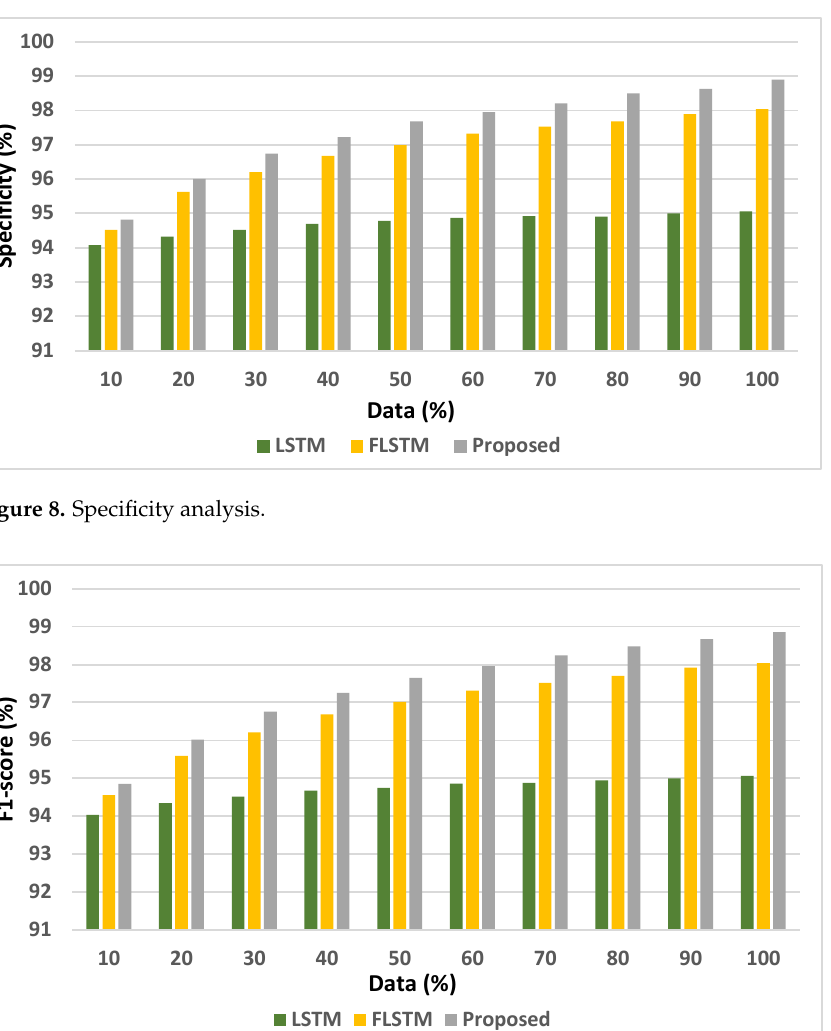
Figure 9. F1-score analysis.